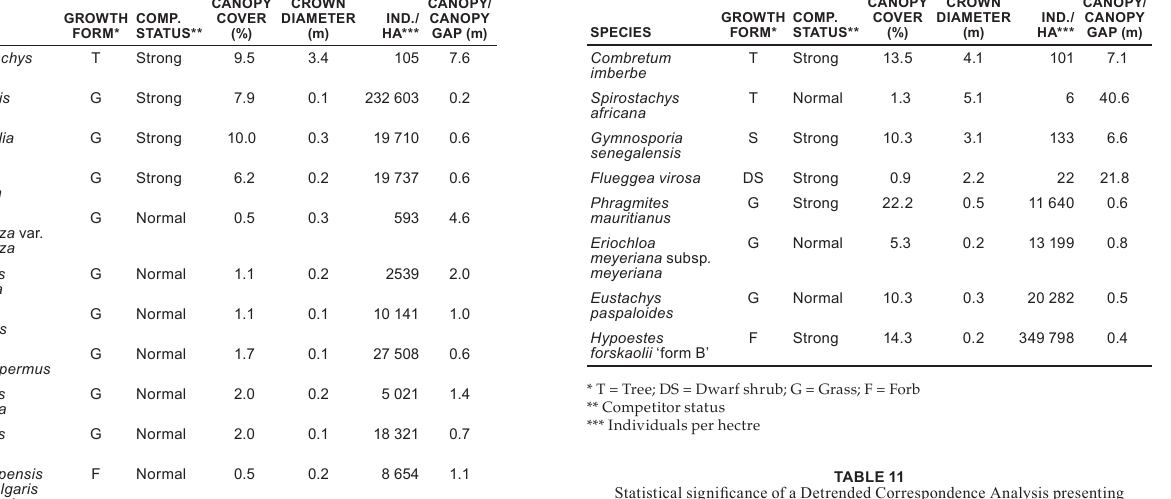
table 11 Statistical significance of a Detrended Correspondence Analysis presenting gradient lengths on four axes. Gradient lengths with standard deviations (SDs) of four or greater have statistical significance (ter Braak & Šmilauer 1998)